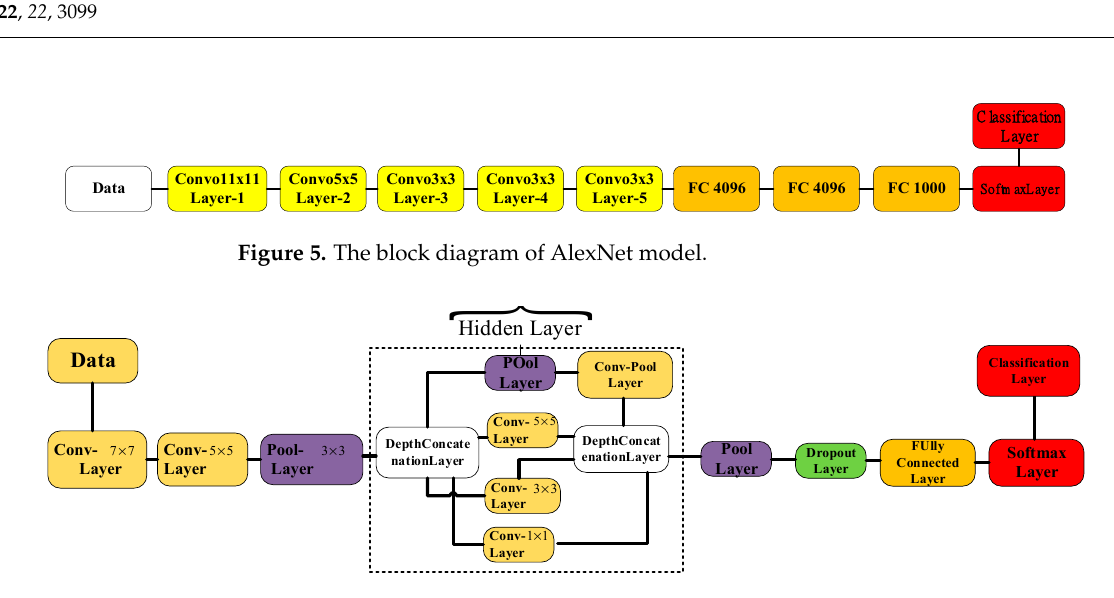
Figure 6. Block diagram of GoogLeNet model .